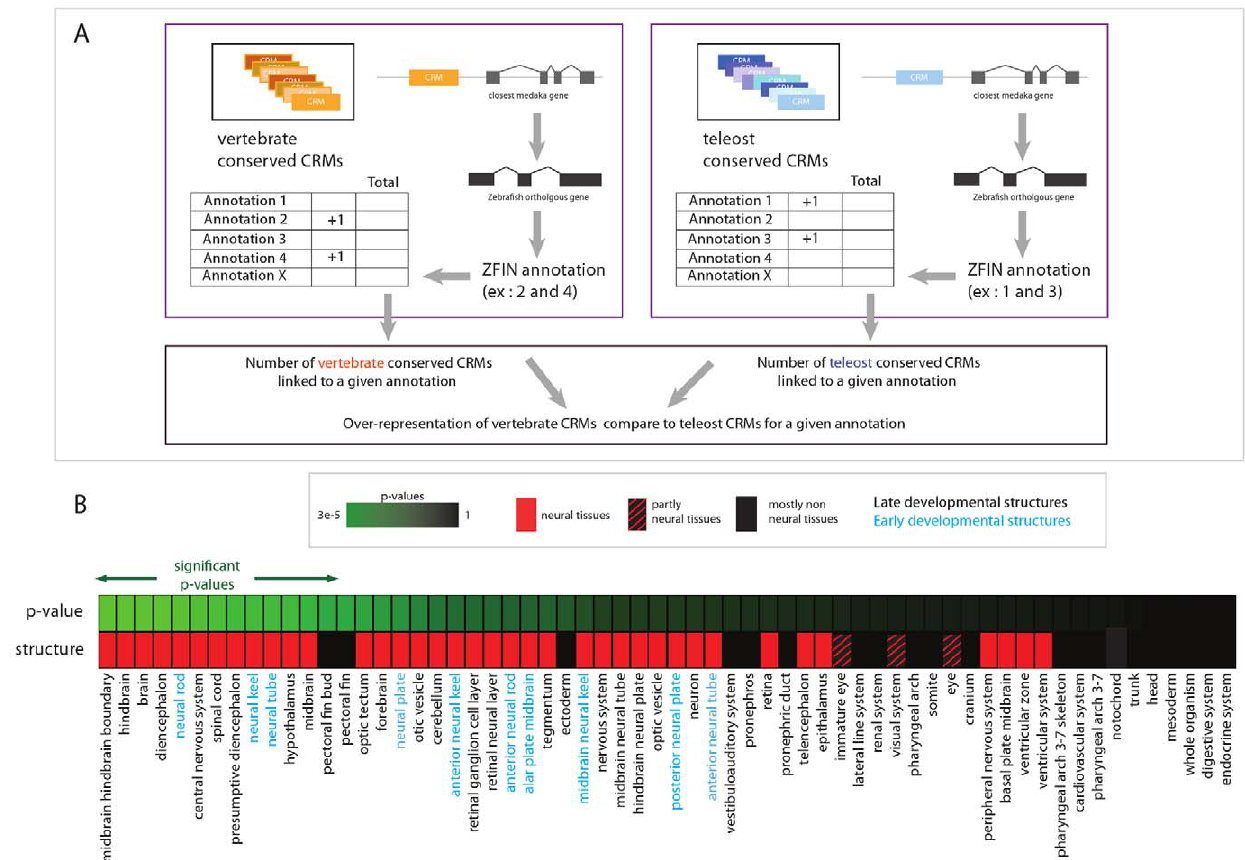
Figure 2. Analysis of the genomic location of CRMs. A. Schema of the procedure. For each predicted CRM, the closest medaka gene is identified. Next we transferred zebrafish in-situ annotation to the medaka orthologous gene. We calculated the significance of the overrepresentation of CRMs showing annotations for specific tissues from the vertebrate conserved dataset compared to a background set (composed of the whole set of predicted CRMs). B. Enrichment of vertebrate conserved CRMs around genes expressed in neuronal tissues. Red squares correspond to neuronal structures. P-values are shown with a color code, the most significant enrichments correspond to the p-values in green, the least significant to p-values in black. Significant p-value cutoff has been determined for a 5% false discovery rate (Benjamini, Hochberg method, see Supplementary Table S4 for numerical values).